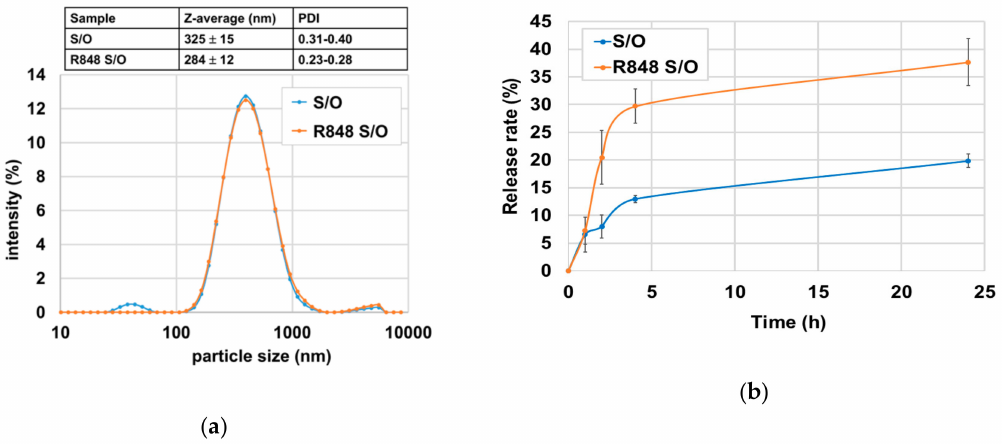
Figure 1. Characterization of the solid-in-oil (S / O) nanodispersions with and without R-848. ( a ) Particle size distribution; ( b ) β -lactoglobulin (BLG) release